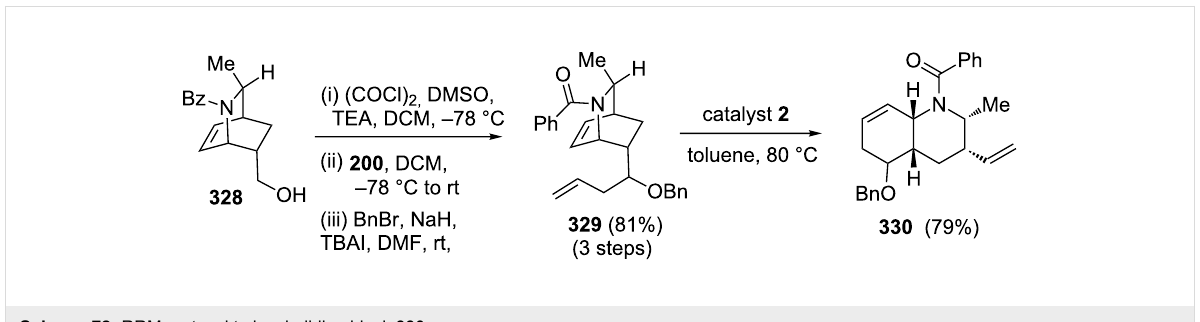
Scheme 72: RRM protocol to key building block 330